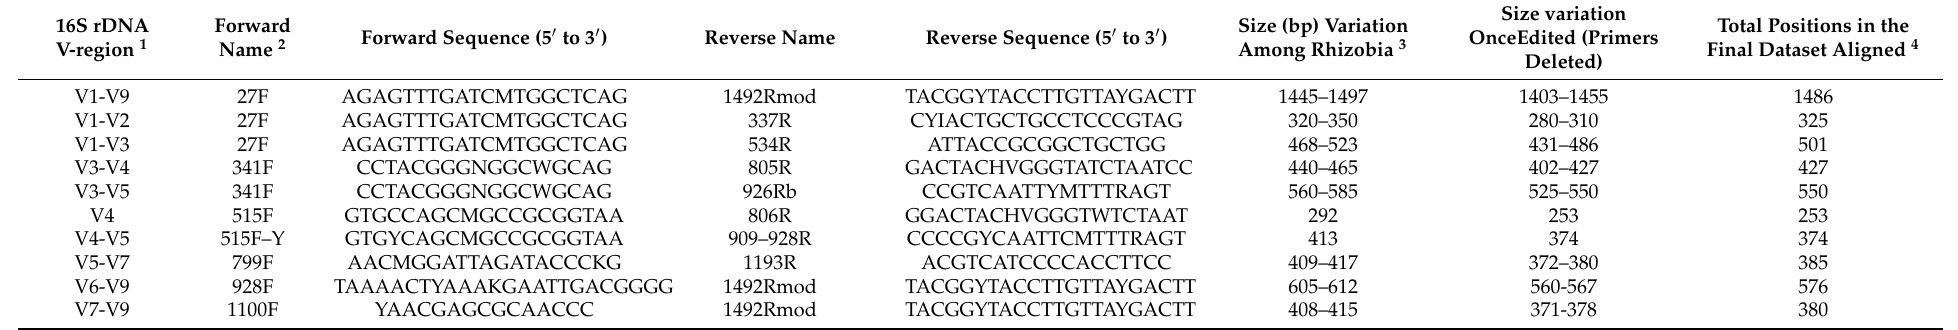
Table 3. Nine commonly used 16S rDNA primers targeting the variable regions and the V1-V9 region and corresponding relevant characteristics used in this study. 16S rDNA V-region